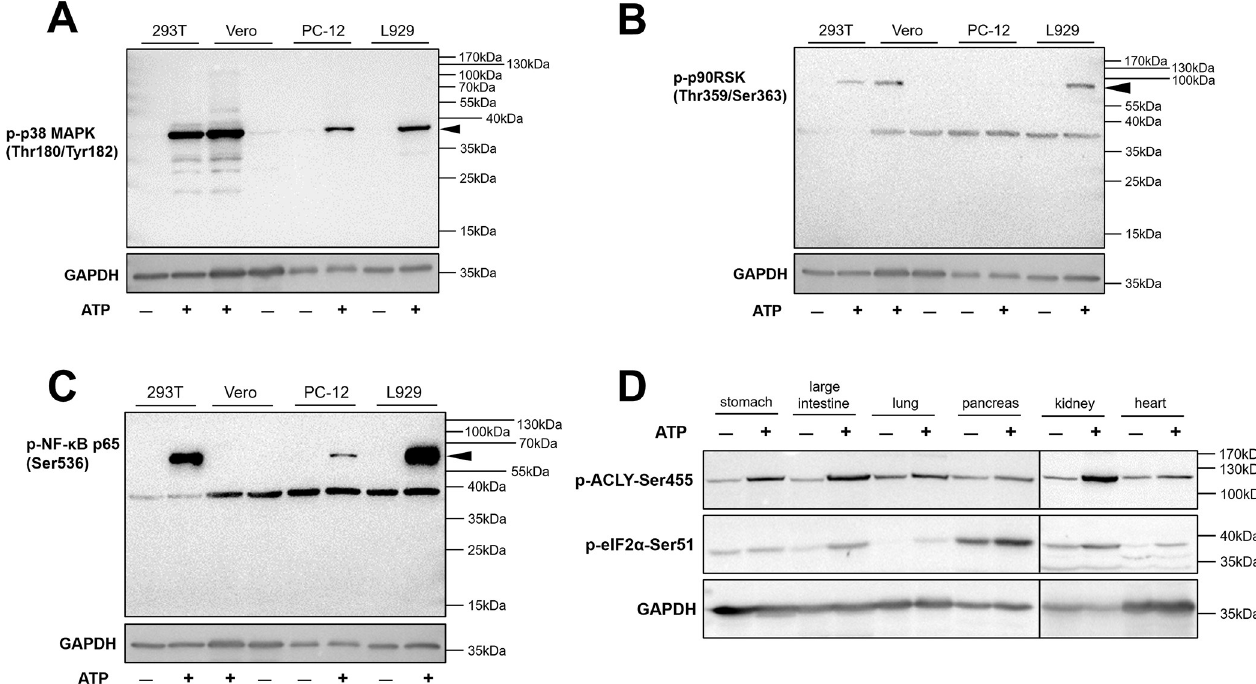
Fig 2. Application of the in vitro phosphorylation system to different types of cells and tissues. (A–C) 293T, Vero, PC-12, and L929 cells were cultured for 24 h, harvested, and then incubated with or without 5 mM ATP in an in in vitro buffer for 30 min. Phospho-p38 MAPK (Thr180/Tyr182), phospho-p90RSK (Thr359/Ser363), and phospho-NF- κ B-p65 (Ser536) were detected in cells by western blotting. (D) Stomach, large intestine, lung, pancreas, kidney, and heart tissues from mice were ground in in vitro buffer and incubated with or without 5 mM ATP for 30 min. Phospho-ACLY (Ser455) and phospho-eIF2 α (Ser51) were detected by western